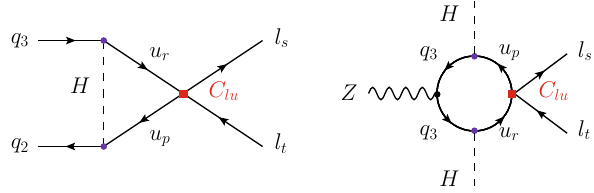
( 1 ) (left) and O (right) via the lq Hl